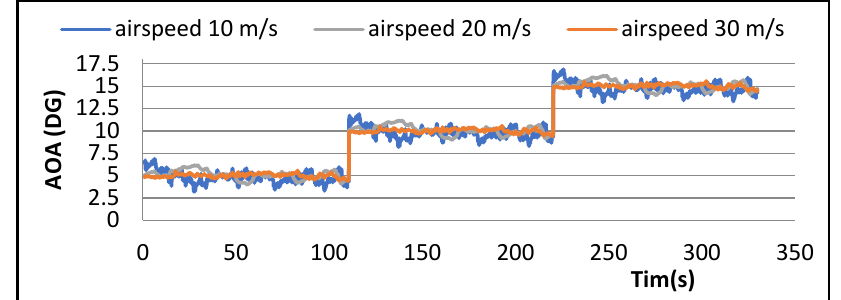
Figure 5. Calibration Angle of fin—Angle of